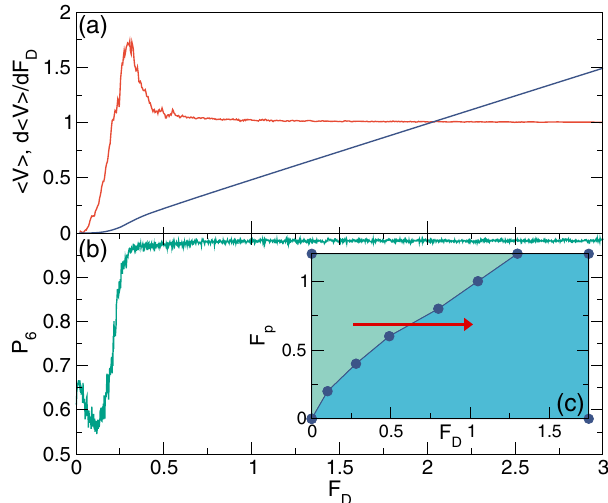
Fig. 1 Dynamical phase transition in a superconducting vortex system. a The velocity V h i versus applied drive F D (blue) and the corresponding d V h i = dF F D (red) for a 2D superconducting vortex system with D vs quenched disorder at vortex density n v = 1.0, pinning density n p = 0.5, pinning force F p = 0.4, and pinning radius r p = 0.3. The curves are from a single simulation and are obtained for a quenching time of t q = 7.5 × 10 6 , sixfold coordinated vortices P 6 vs F D . A nonequilibrium transition from a diagram as a function of F p versus F D for the same system highlighting the disordered phase (green) and the dynamically ordered phase (blue). The arrow indicates the direction in which the transition is crossed at different sweep rates. The error bars representing the uncertainty in the location of the depinning transition, obtained from multiple realizations, are smaller than the symbols.